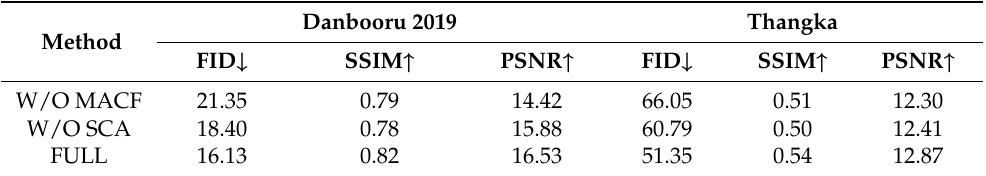
Table 2. The ablation study validated the effectiveness of the proposed adaptive-instance-normalized color fusion (MACF) and skip connection attention (SCA). With the presence of both MACF and SCA in the model (row 3 of Table 2), our model achieved the best results. FID [34] score: a lower score is better. PSNR and SSIM score: a higher score is